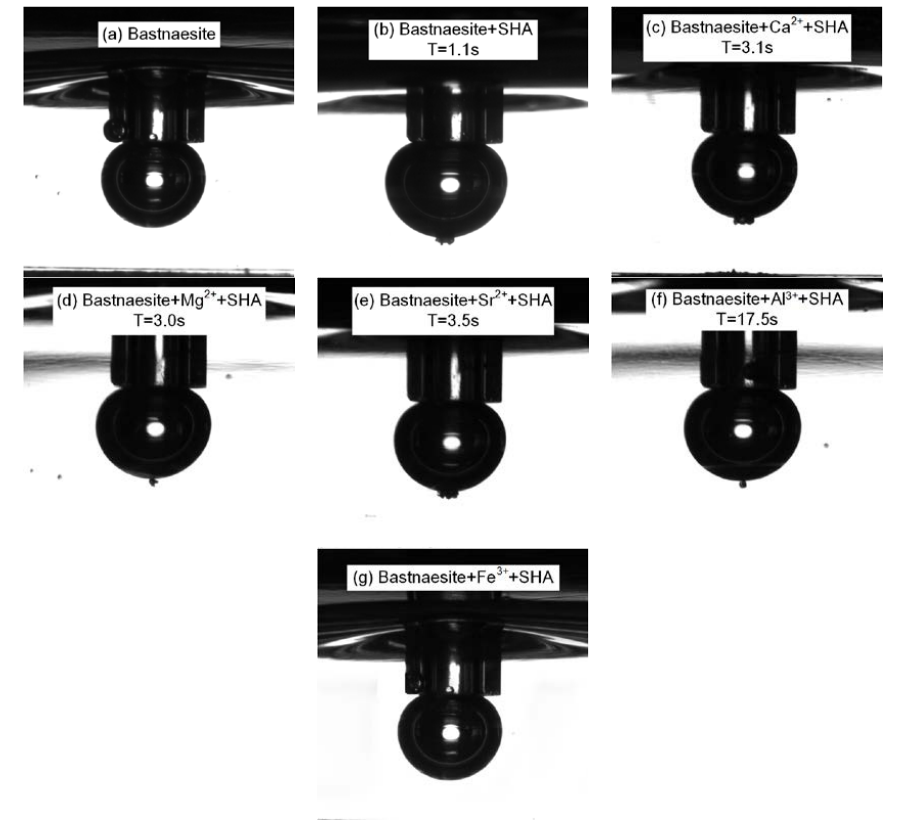
Figure 7. Influence of metal ions on induction time of ( a ) Bastnaesite; ( b ) Bastnaesite + SHA; ( c ) Bastnaesite + Ca 2+ + SHA; ( d ) Bastnaesite + Mg 2+ + SHA; ( e ) Bastnaesite + Sr 2+ + SHA; ( f ) Bastnaesite + Al 3+ + SHA; ( g ) Bastnaesite + Fe 3+ + SHA (pH = 8, metal ions: 1 × 10 − 4 mol/dm 3 , SHA: 5 × 10 − 4 mol/dm 3 ).